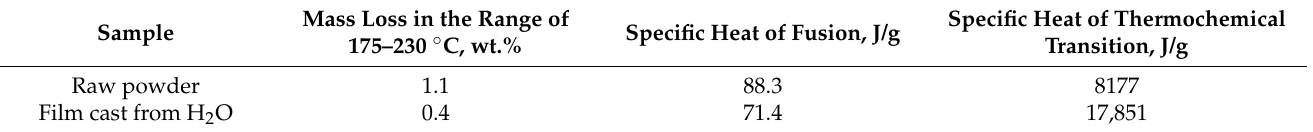
Table 1. Specific heat of the thermal effect in the range of 175–230 ◦ C for PVA raw powder and film calculated by two